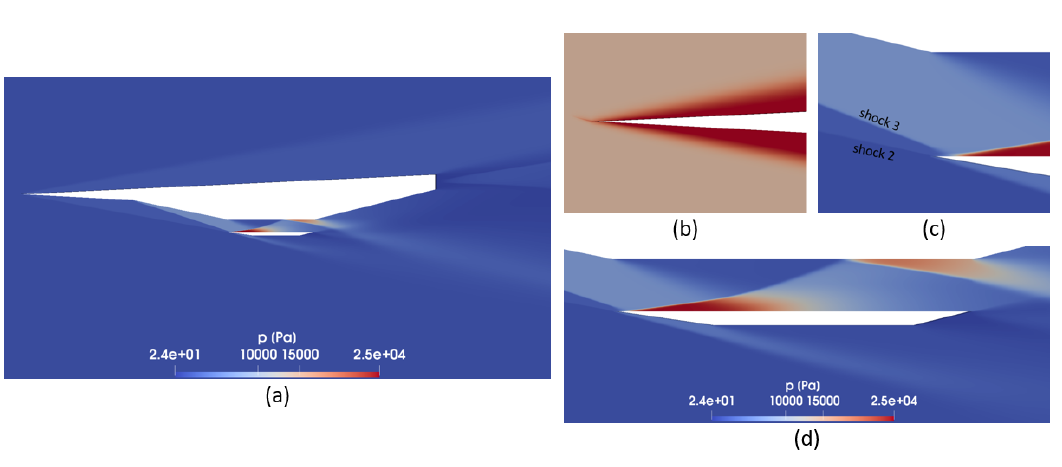
Figure 10. Pressure field of case 1 for AoA = 0 ◦ , ( a ) all the aircraft, ( b ) attached leading edge (different colour scale), ( c ) tip of the lower edge of the scramjet, ( d ) scramjet